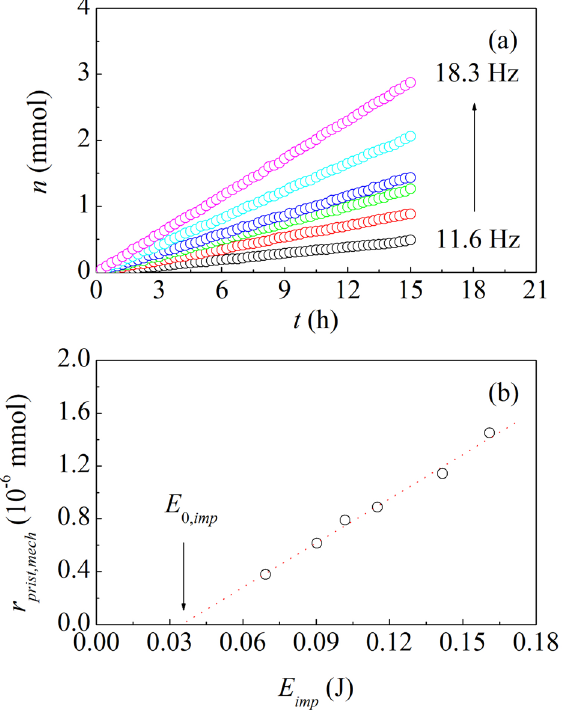
Figure 4. ( a ) The number of CO moles reacted, n , as a function of time, t , during ball milling in the presence of a single milling ball. Data refer to CO reacted over pristine catalyst powders never exposed to H 2 for catalyst activation purposes. The different datasets were obtained using a milling frequency of 11.6 Hz (black), 13.3 Hz (red), 14.6 Hz (green), 15.0 Hz (blue), 16.6 Hz (cyan), and 18.3 Hz (magenta). ( b ) The number of CO moles reacted over pristine catalyst powders during individual impacts, n prist , imp , as a function of the impact energy, E imp . The best-fitted line is shown (dotted, red). The minimum impact energy required to activate the reaction, E 0, imp , is